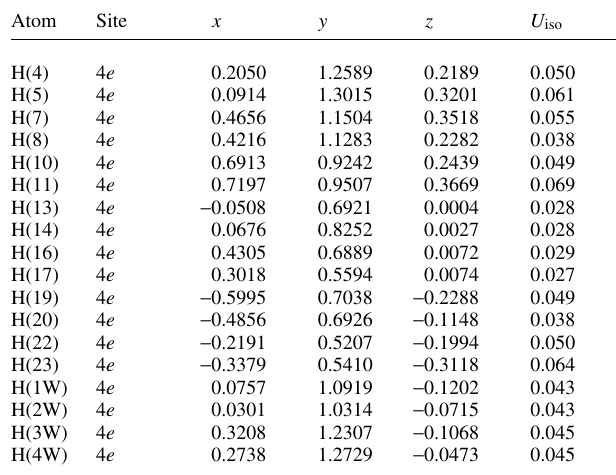
Table 1. Data collection and